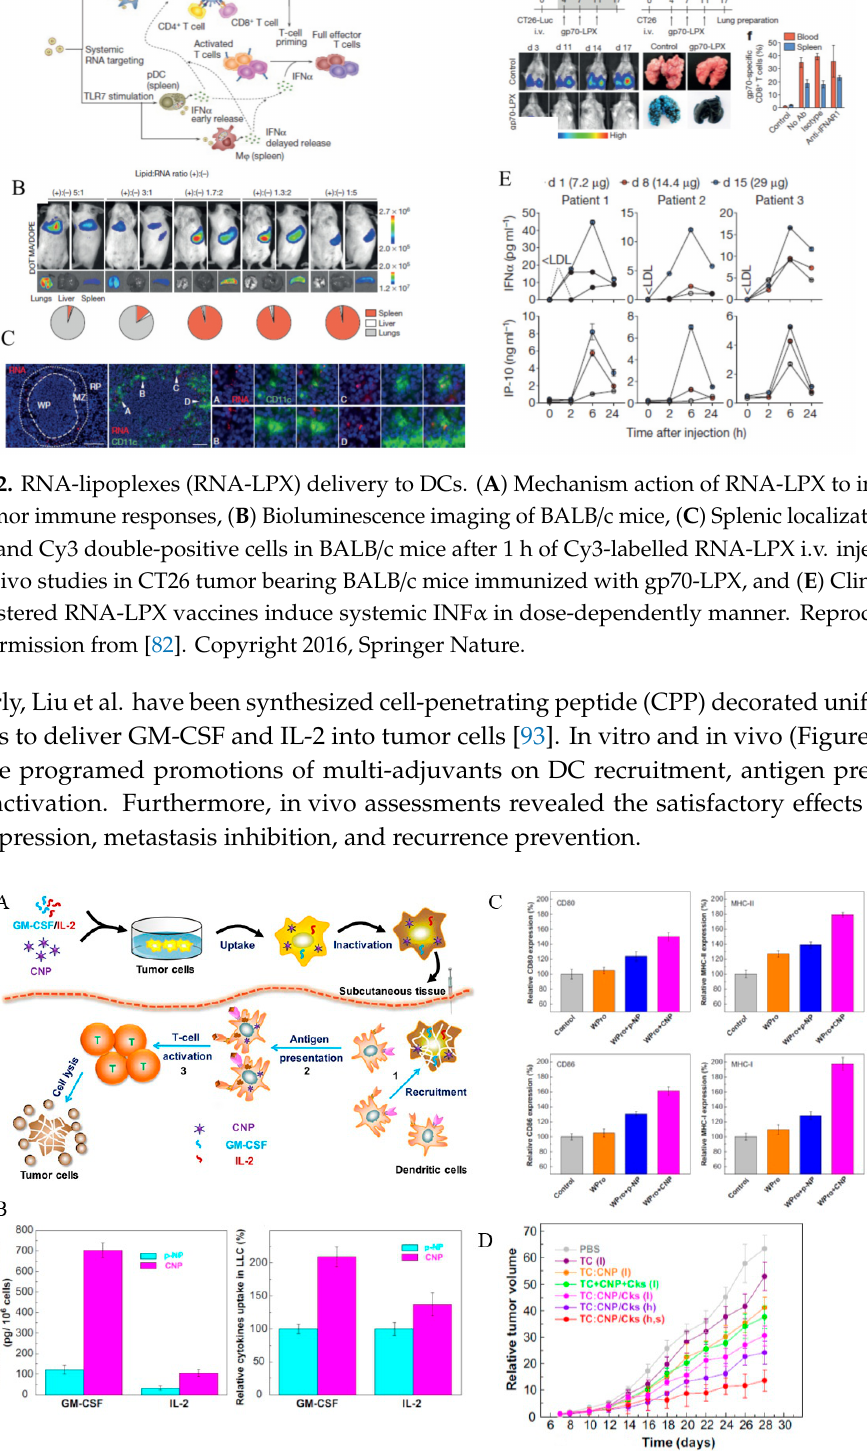
Figure 3. ( A ) Scheme of multi-adjuvant WCTV to initiate anti-tumor immunity, ( B ) bioavailability and cellular up take of GM-CSF and IL-2 in LLC cells after incubating with nanoparticles (NPs) for 24 h, ( C ) relative expressions of CD80, CD86, MHC II, and MHC-I molecules after treatment with whole tumor cell lysate protein (WPro), p-NP, and CNP for 24 h and ( D ) Relative tumor volume of LLC tumor bearing mice after immunization with multi-adjuvant WCTVs compared with other vaccine groups. Reproduced with permission from [93]. Copyright 2013, Elsevier